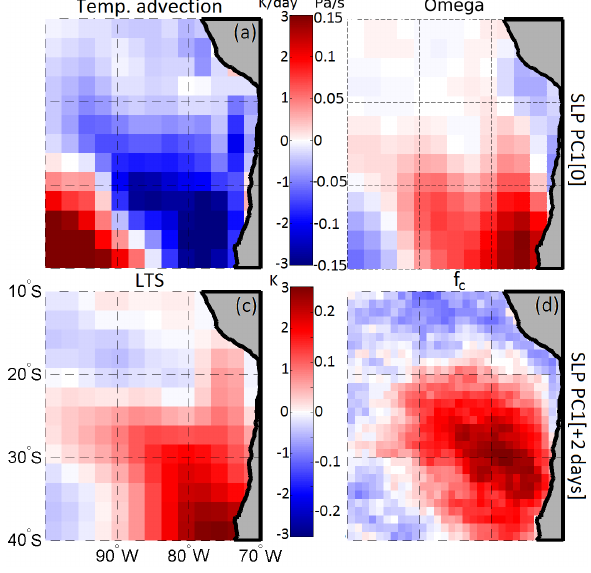
Fig. 10. Composite differences (not fractional) of (a) tempera- ture advection on SLP PC1[0], (b) omega (Pa s − 1 ) at 850hPa on SLP PC1[0] (red indicating strong subsidence), (c) LTS on SLP PC1[+2], and (d) f c on SLP PC1[+2].